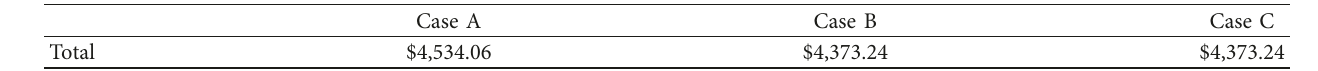
Table 8: Summary of truss labour.